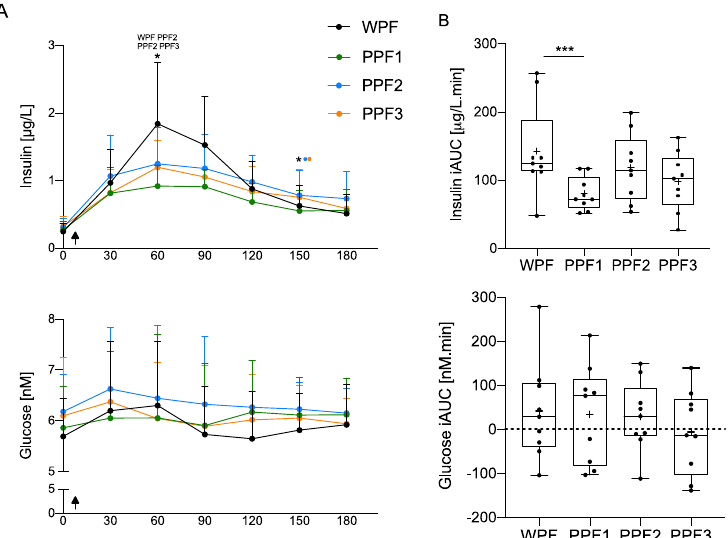
Figure 5. Insulin, but not glucose, plasma concentrations ( A ) over time (min), and ( B ) their iAUC, showed a significantly different response post-WPF than PPF 1, 2, or 3 meals. Values are mean ± SD ( n = 9). Arrows indicate the ingestion of the meal. Concentration over time data were assessed by 2-way repeated measurements (time × treatment) ANOVA, and iAUC was compared with a 1-way repeated measures (treatment) ANOVA. Significant at p < 0.05 (*), p or p < 0.001 (***). The products’ names above the asterisk indicate the treatments in which postprandial insulin concentrations significantly differ at that time. iAUC, incremental area under the curve; PPF, plant protein fibre; WPF, whey protein fibre.